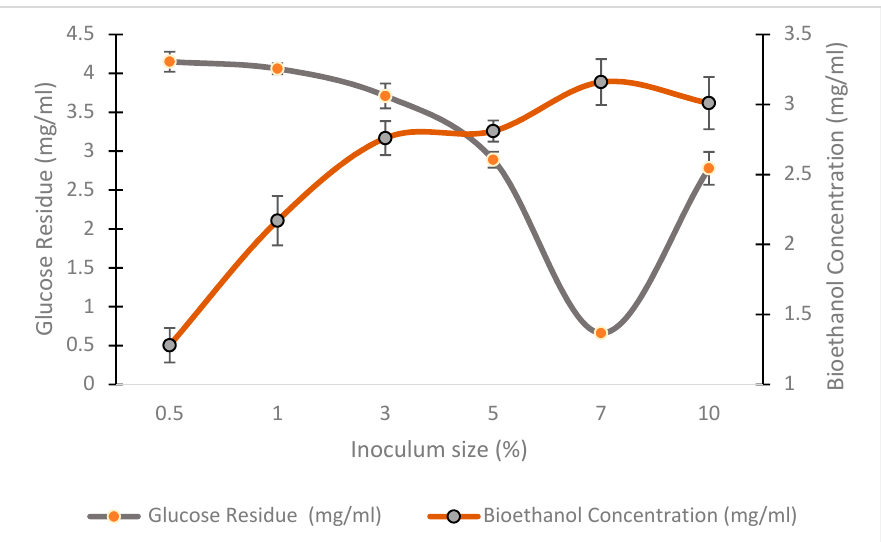
Figure 11. Effect of inoculum size on the production of bioethanol using G4 yeast isolate and the residual glucose concentrations.